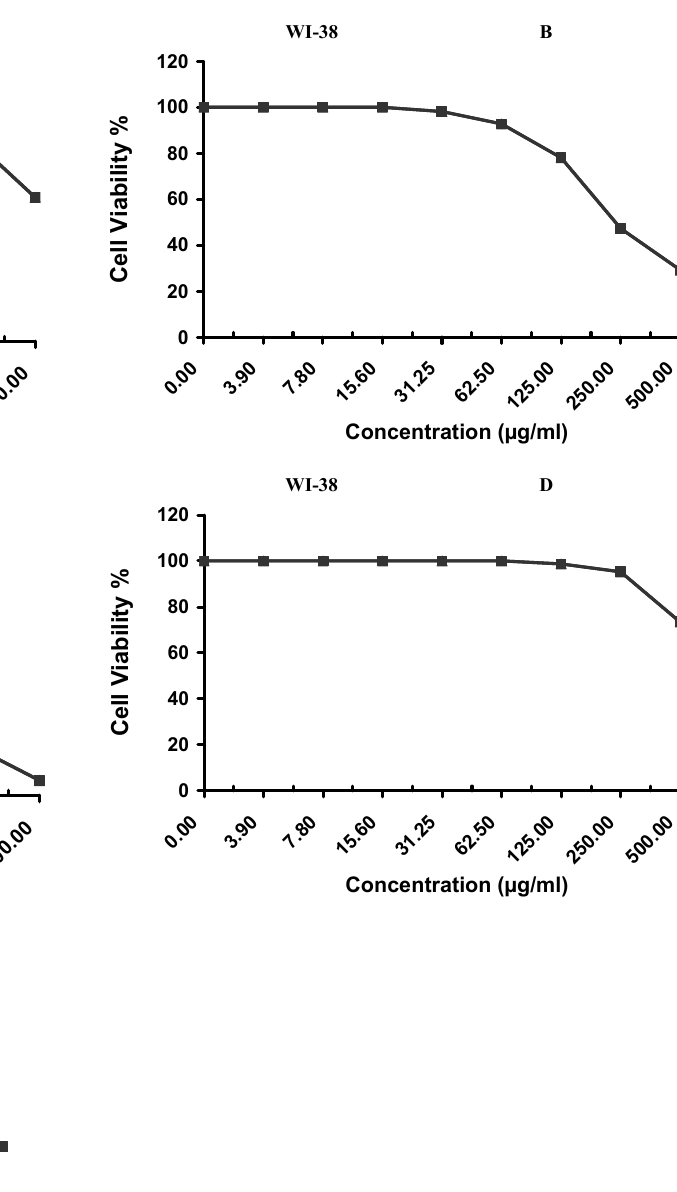
Figure A5. The percentage of cell viability of liver cancer cell lines (HepG-2) upon treatment with different doses of the test samples. ( A ) the unloaded PLGA NPs, ( B ) the PLGA-Cf-F 1 NPs, ( C ) the PLGA-Cf-F 2 NPs and ( D ) the PLGA-Cf-F 3 NPs. Finally, graph ( E ) is for the free coffee extract.